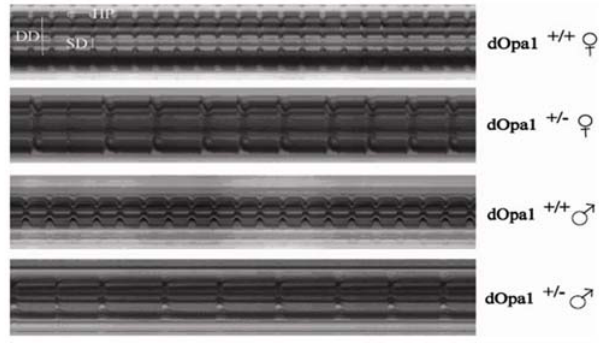
Figure 4. Representative M-mode traces (10 s) of semi-intact Drosophila from different genotype and sex. M-modes were created by electronically ‘‘cutting’’ out a single specified vertical row of pixels that span the heart tube from every frame of the movie, and aligning them horizontally. The M-modes describe the vertical movement of the heart walls in time. In these representative M-modes of 3-week-old dOpa1 + / + and dOpa1 + / 2 Drosophila , it is seen that mutation causes increased heart period, due primarily to increased diastolic intervals. The dilation of mutant heart tube is also visible.